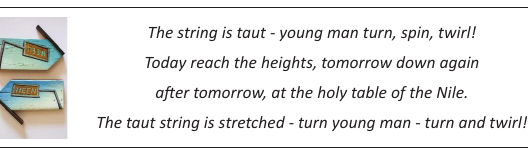
FIGURE 14: ‘The String Is